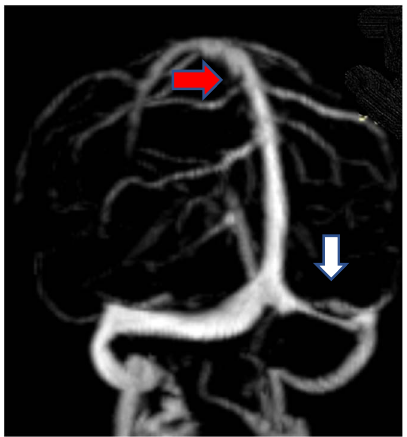
Figure 1. MR-venography Maximum Intensity Projection (MIP) range reveals thrombosis of the superior sagittal sinus (red arrow) and the left lateral sinus (white arrow) at onset.